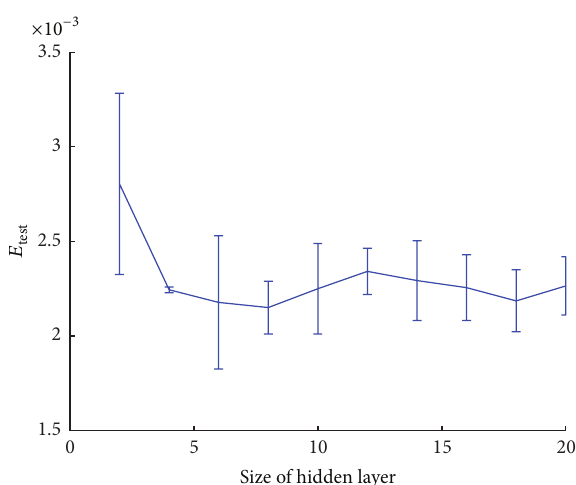
Figure 6: Validation error as function of number of neurons in the hidden